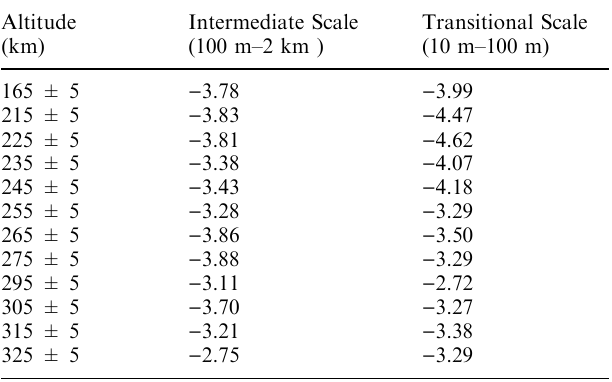
Table 1. Variation of spectral index, ‘ n ’ with altitude for the intermediate and transitional scale electron density irregularities Altitude Intermediate